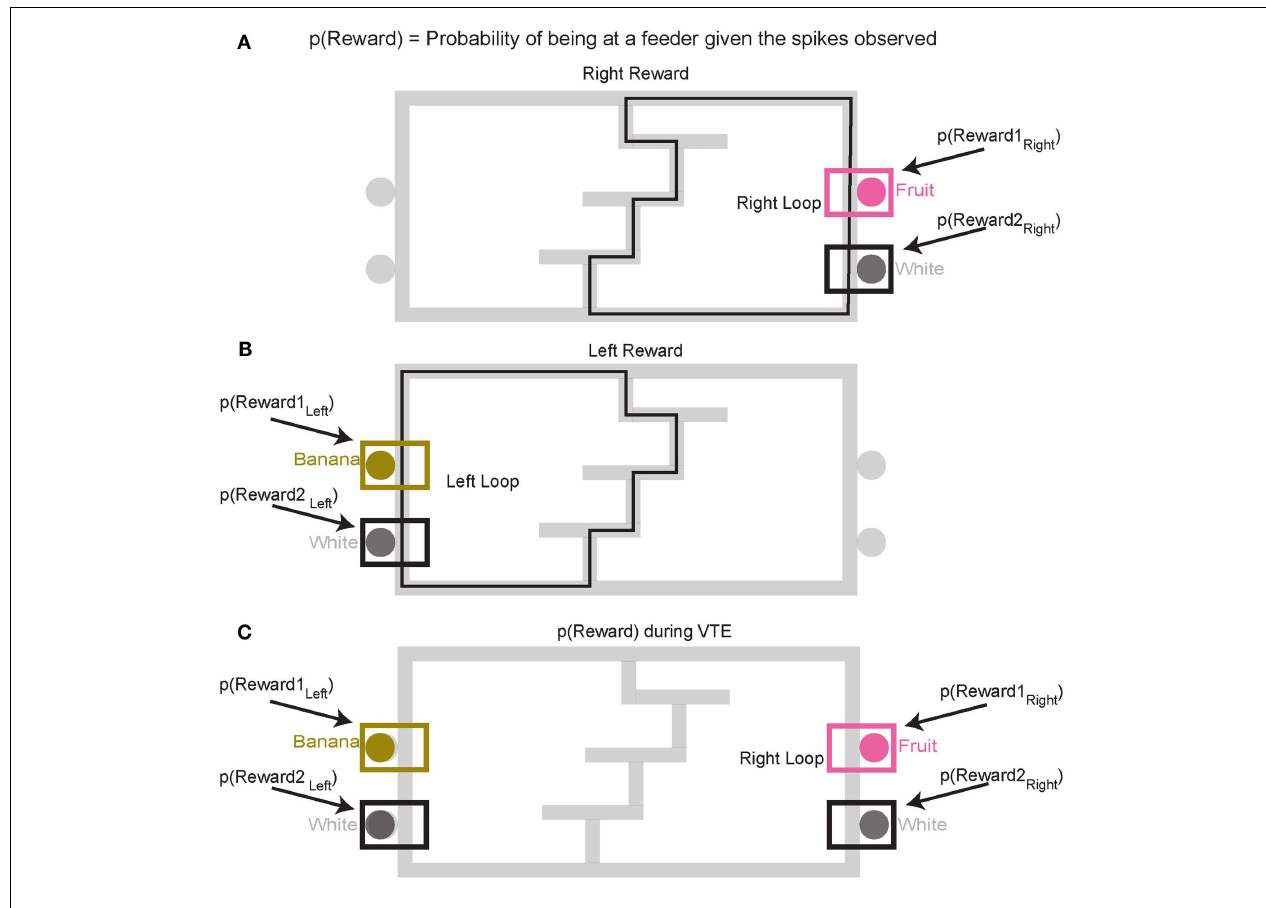
receiving reward when the animal is at the reward site, p (Reward). It should be noted that we make no claims that OFC represents space.When calculating the probability of reward [ p (Reward)] for the rightward loop, only the two right feeder locations (A) are considered in the calculation of p (Reward). Conversely, when considering the leftward loop (B) , only left side feeders are considered in the calculation of p (Reward). DuringVTE events, p (Reward) is averaged across all four feeder locations (C)